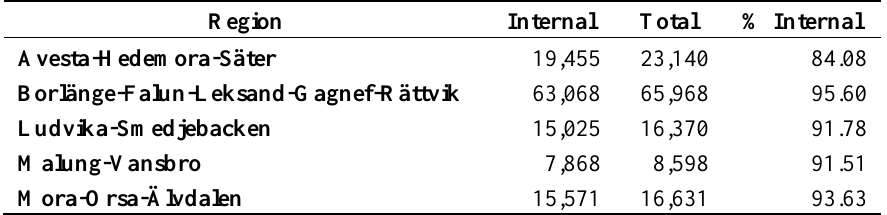
Table 8. Net residence-based self-containment at step 671.